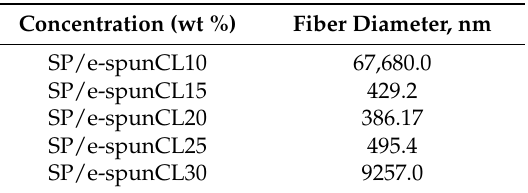
Table 3. Fibers diameters of electrospun SPEEK/Cloisite fibers.